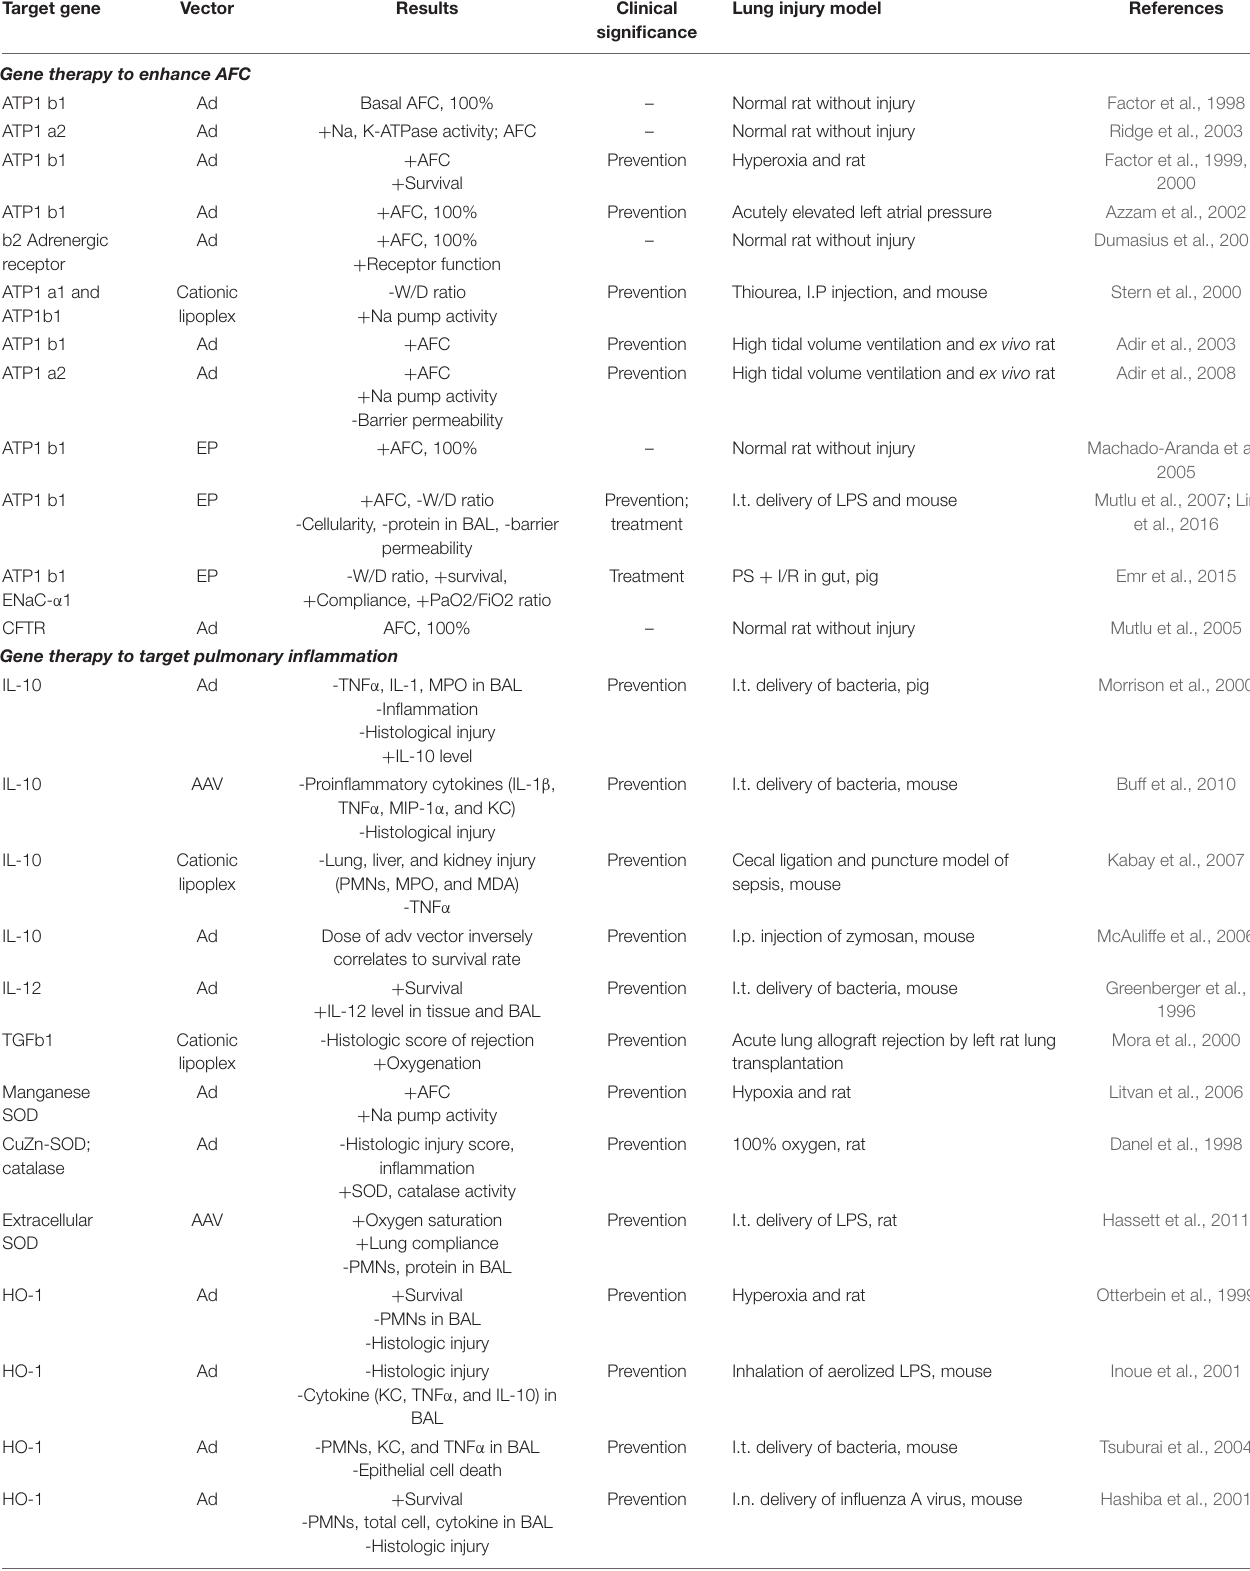
TABLE 1 | Gene therapy approaches for acute respiratory distress syndrome